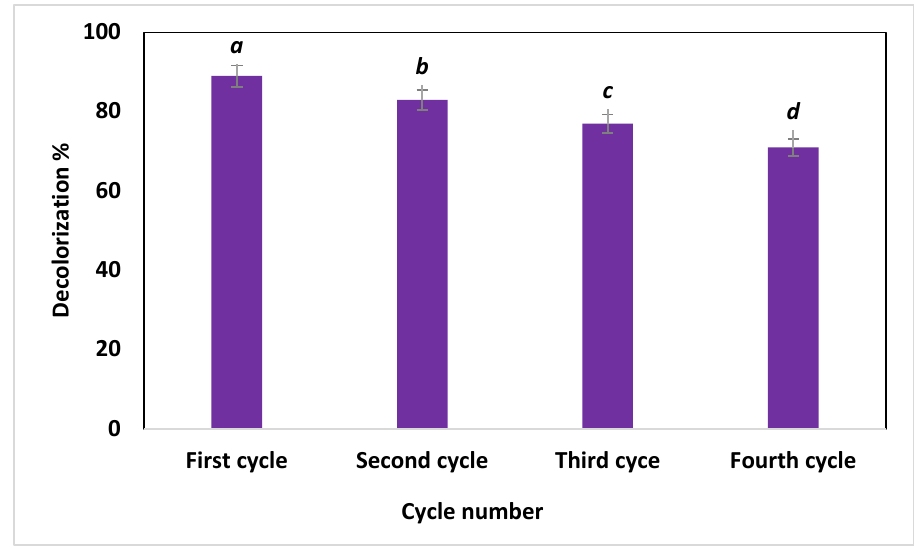
Figure 9. The reusability assessment of SeNPs for decolorization of malachite green dye After 240.0 min. Letters a, b, c, d Mean significance power